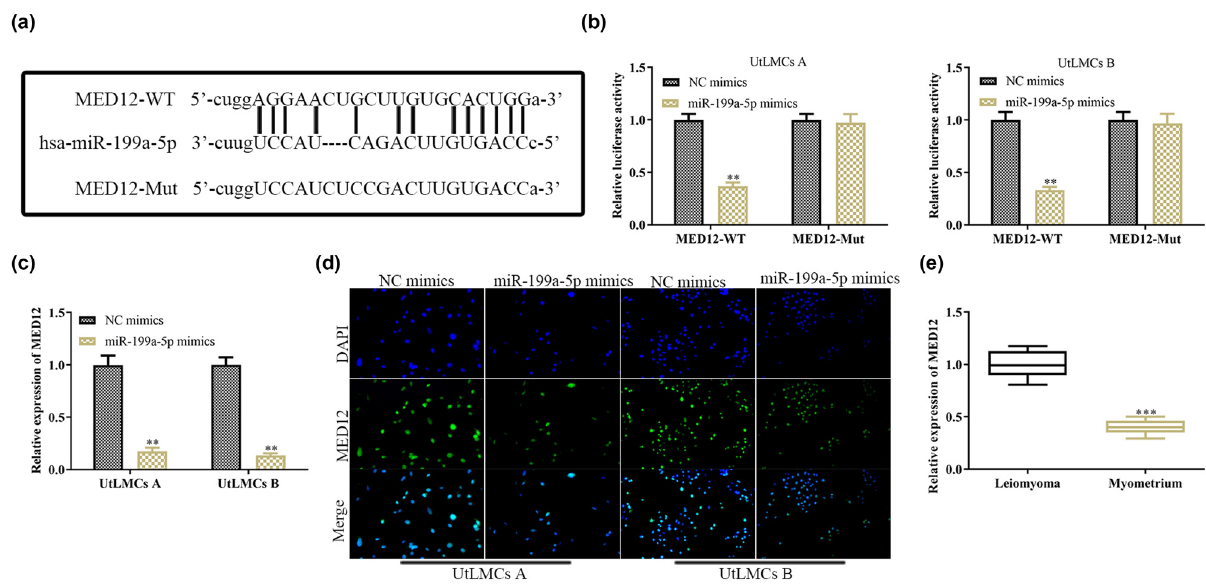
Figure 3: MED12 is a target of miR - 199a - 5p in ULM. ( a ) Bioinformatics study showed that 3 ′ - UTR of MED12 contained a conserved binding site for miR - 199a - 5p. ( b ) Dual - luciferase reporter assay to validate the MED12 as a target of miR - 199a - 5p. ( c and d ) qPCR and immuno fl uores - cence analyses of mRNA and protein expression level of MED12 in response to miR - 199a - 5p overexpression. ( e ) Relative expression level of MED12 in 40 paired uterus leiomyoma tissues and adjacent normal myometrium tissues. All values are presented as mean ± SD from at least three separate experiments. ** P < 0.01 and *** P < 0.001 vs NC mimics